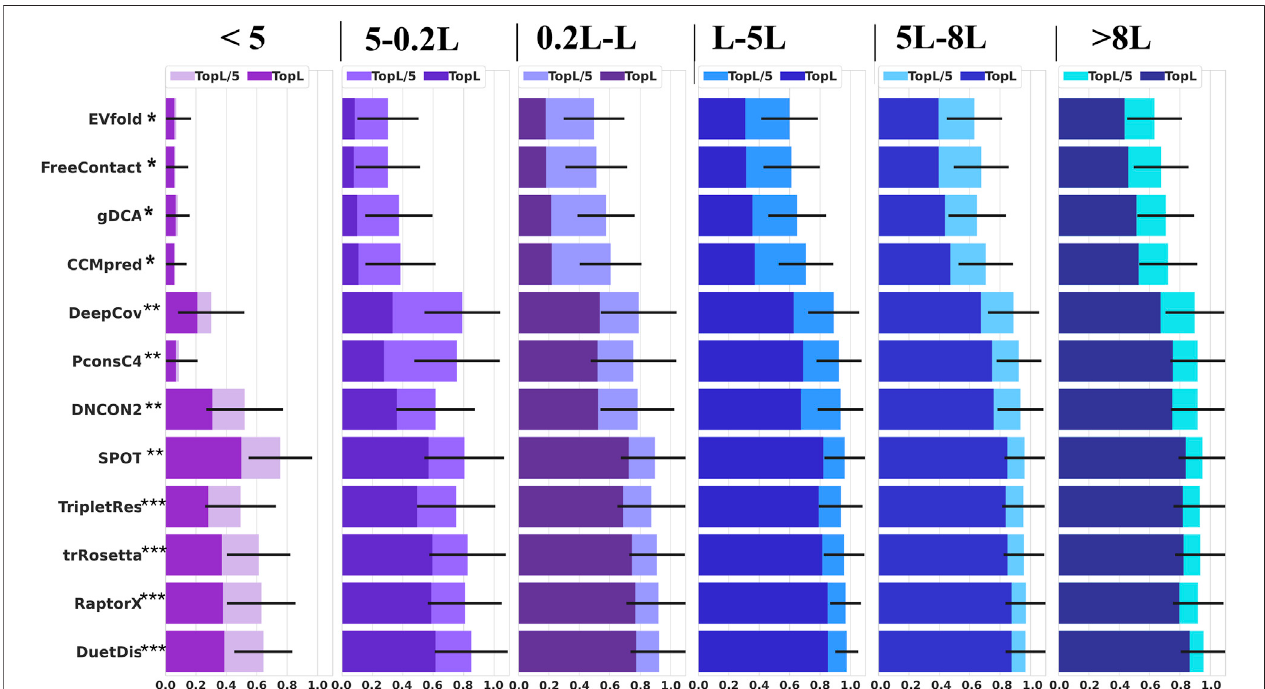
FIGURE6| Predictionprecisionsofdifferentmethodsforall-range,top-L,andtop-L/5predictionswiththevariationof N eff .Theerrorbaristhestandarddeviationof all precisions (for top L/5 predictions) in each sub-test